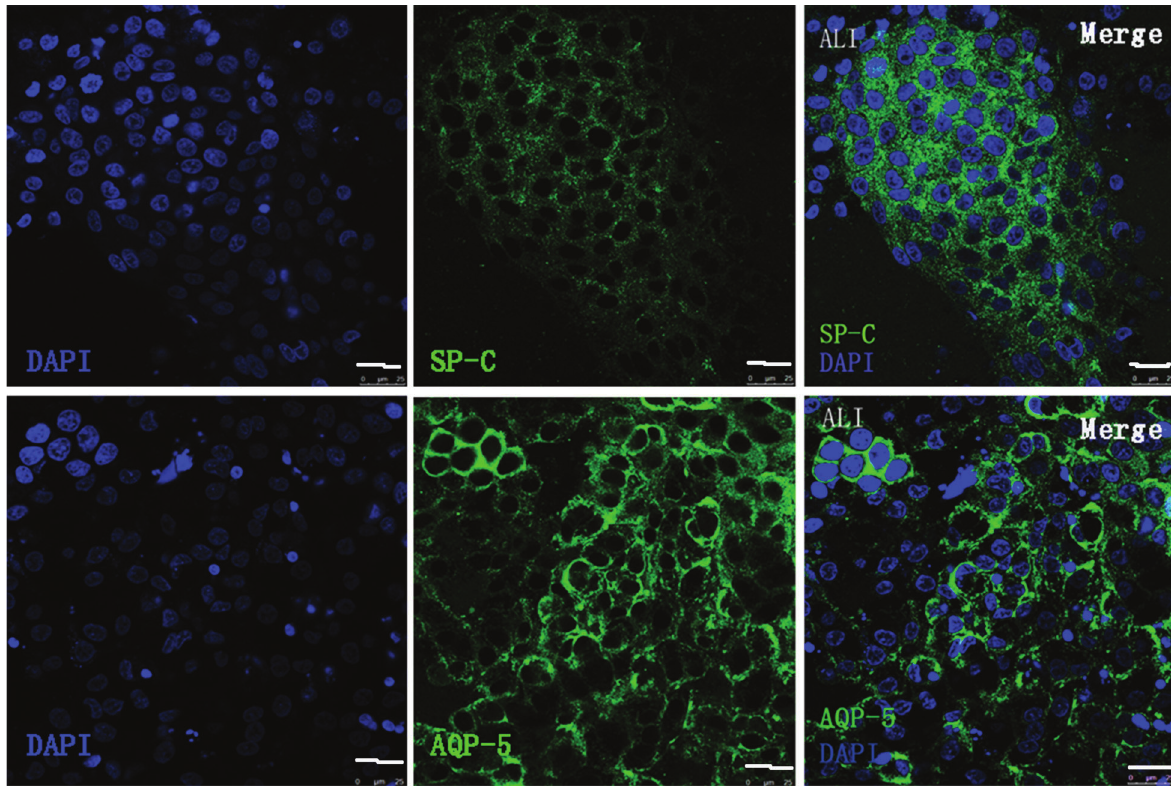
Figure 4. Expression of alveolar epithelial cell type markers determined by immuno fl uorescent staining. Two-week-old membranes of A549 air-liquid interface (ALI) cultures were used for determination of the expression of AECI cell speci fi c marker aquaporin-5 (AQP-5) and AECII cell marker surfactant protein C (SP-C) by immuno fl uorescent staining assay. The expression of both of AQP-5 and SPC was observed on the cytomembrane and in the cytoplasm of distinct subset cells, respectively. Magni fi cation bars: 25 m